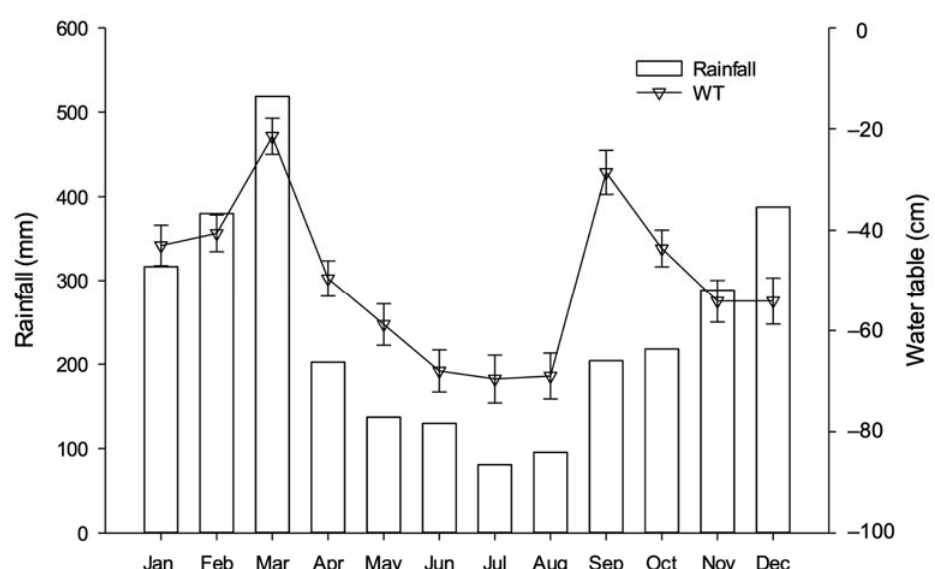
Figure 2. Monthly cumulative rainfall and water table (WT) with standard error bars.